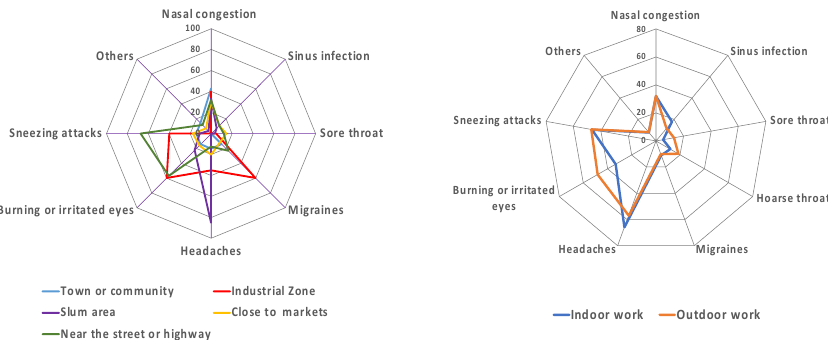
Figure 4. Health symptoms of socio-economic groups among five districts.